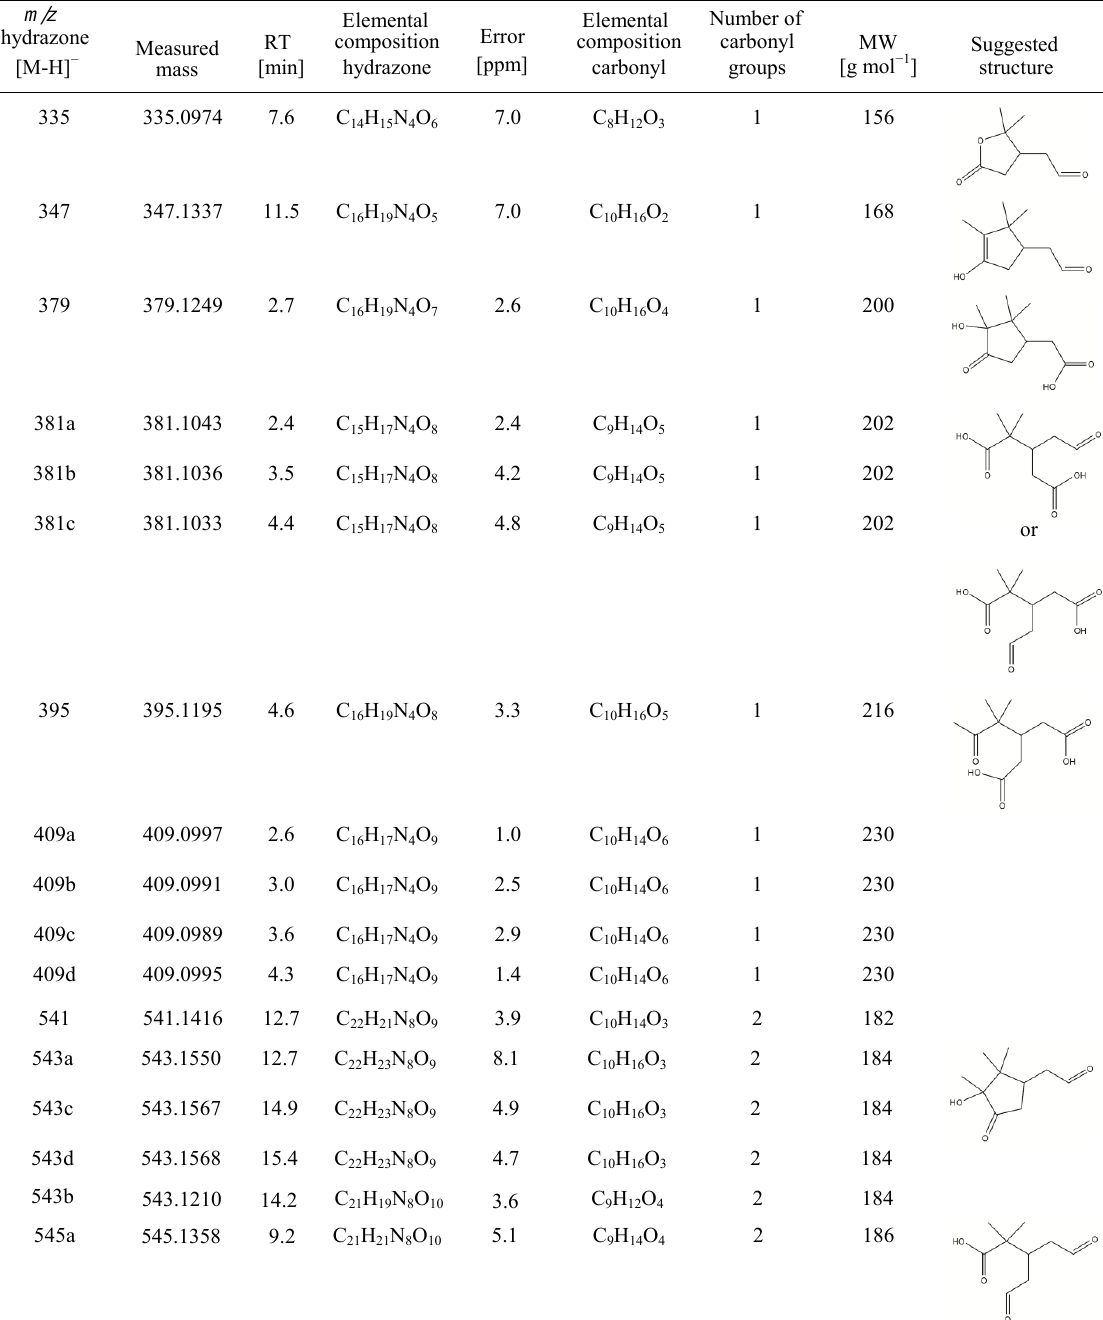
Elemental Error composition [ppm] carbonyl